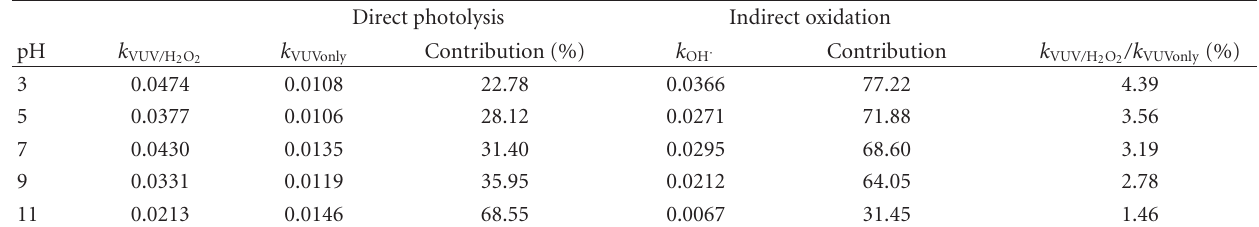
Table 2: The summary of the pseudo-first-order decomposition rate constant, k (min − 1 ), of Acid Orange 8 by direct photolysis and the VUV/H 2 O 2 process.